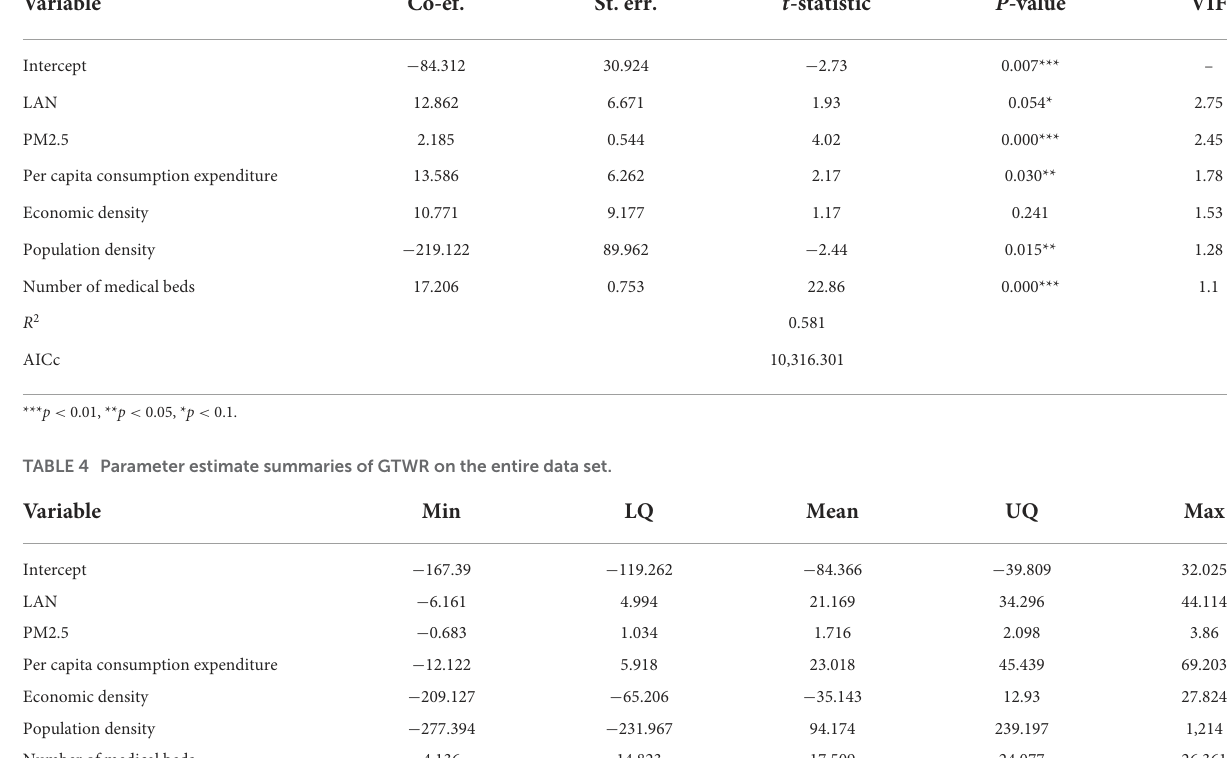
TABLE 3 Parameter estimate summaries of OLS on the entire data set. Variable